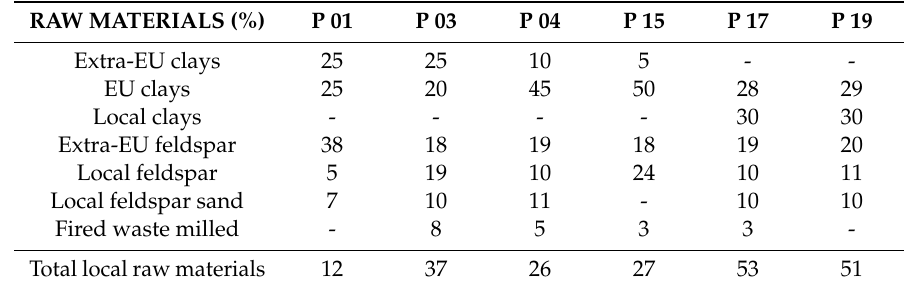
Table 1. Alternative compositional scenarios of ceramic bodies (EU = European union; P = identification code of the